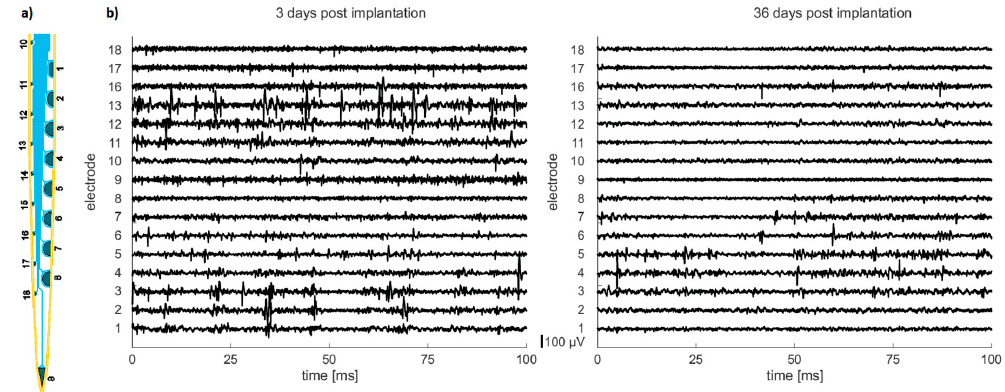
Figure 11. In vivo chronic recordings of spontaneous neural activity in rat visual cortex using a 2 mm long silicon-based free-floating probe with 18 microelectrodes ( a ) 3 days and 36 days after implantation demonstrate the long-term capability of recording single unit activity ( b